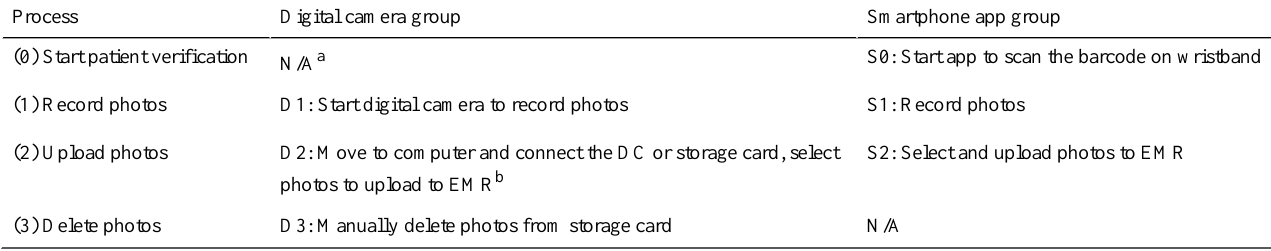
Table 1. Photography processes for the digital camera and smartphone app